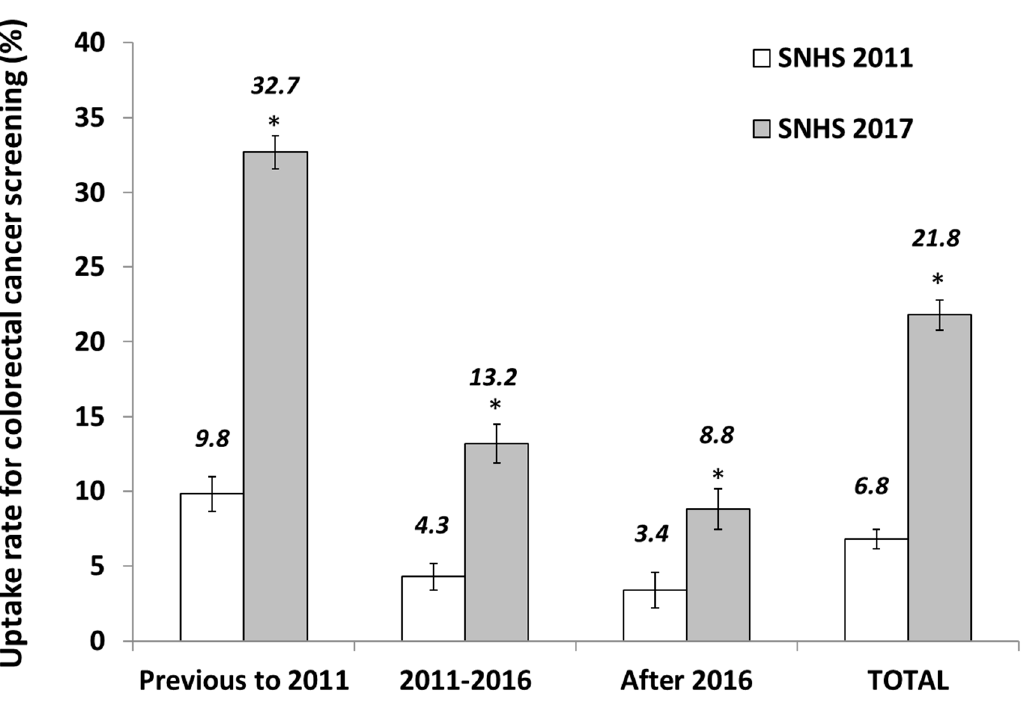
Figure 1. Uptake rates for colorectal cancer screening obtained from the 2011 and 2017 Spanish National Health Surveys (SNHSs) for people aged 50–69 years, according to the year the colorectal screening was implemented. Error bars represent a confidence interval of 95%. * p -value < 0.001 for the data from the Spanish National Health Survey 2011.